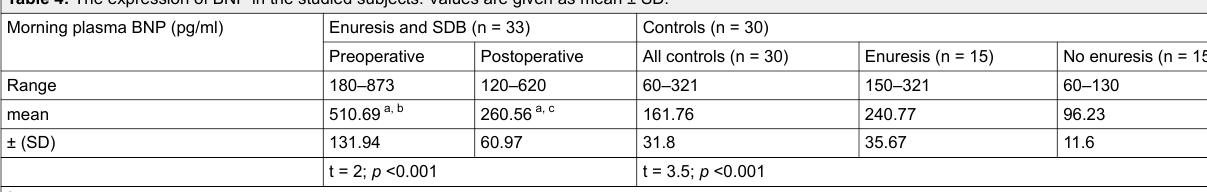
Table 4: The expression of BNP in the studied subjects. Values are given as mean ±